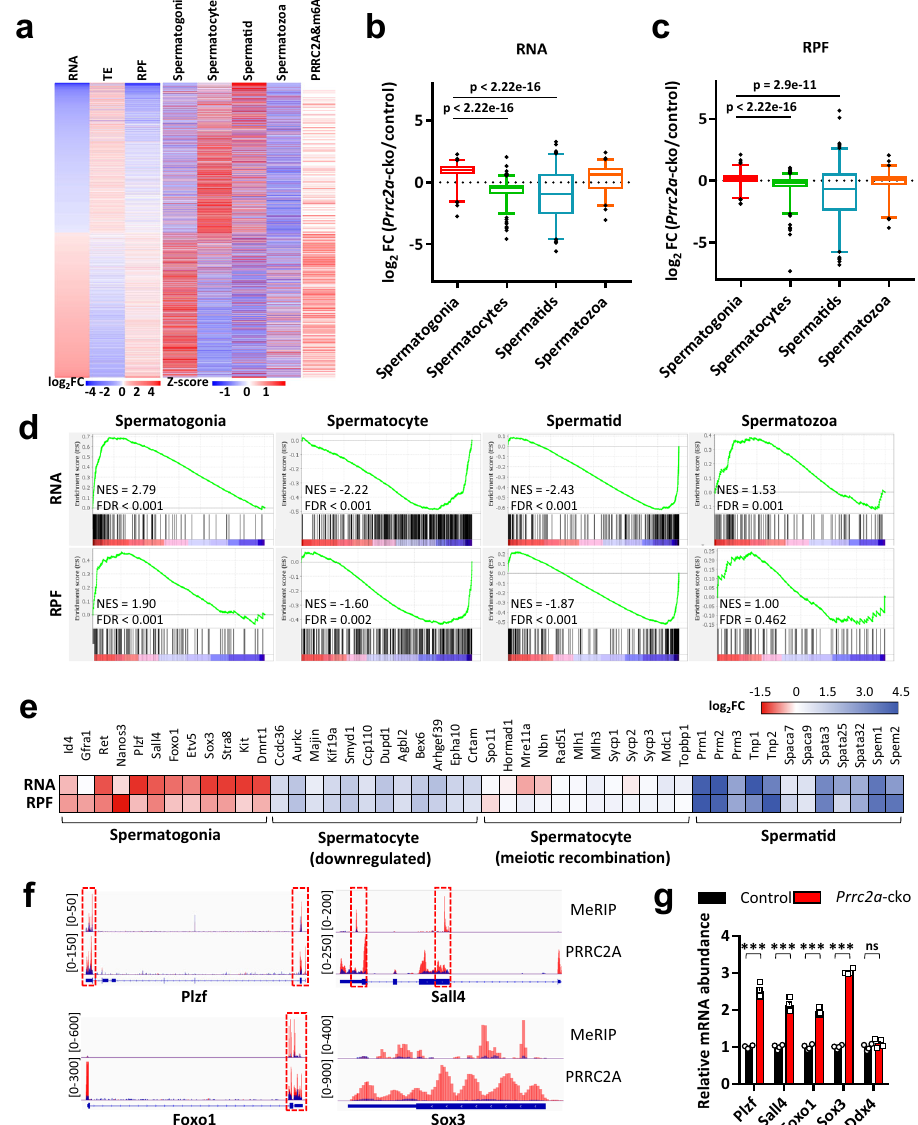
Fig. 6 | PRRC2A de fi ciency causes defective transcriptome transition from spermatogonia to spermatocytes. a Heatmap showing the changes of RNA abundance, TE, and RPF for genes with differentially RNA abundance ( p -adjus- ted<0.05 as cutoff) in PRRC2A-null spermatocytes versus control spermatocytes. Genes with PRRC2A-binding m6A-modi fi ed sites and their expression levels in different cell types were correspondingly shown. b , c Box plots show the RNA and RPFabundanceofcell-type-speci fi cgenesfromRNA-seqandRibo-seqdata( Prrc2a - cko versus control, two-sided Wilcox test) ( n =186, 395, 267, 125 genes). The box indicates the lower (25%) and upper (75%) quantile and the white line indicates the median. Whiskers extend from 2.5% to 97.5% percentile, non-outlier data points. d GSEA analysis of cell-type-speci fi c gene sets in RNA-seq and Ribo-seq data